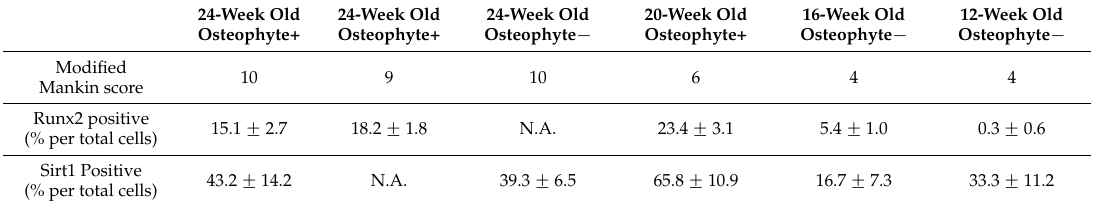
Table 2. Summary of immunohistologic analysis in OA mouse articular cartilages.